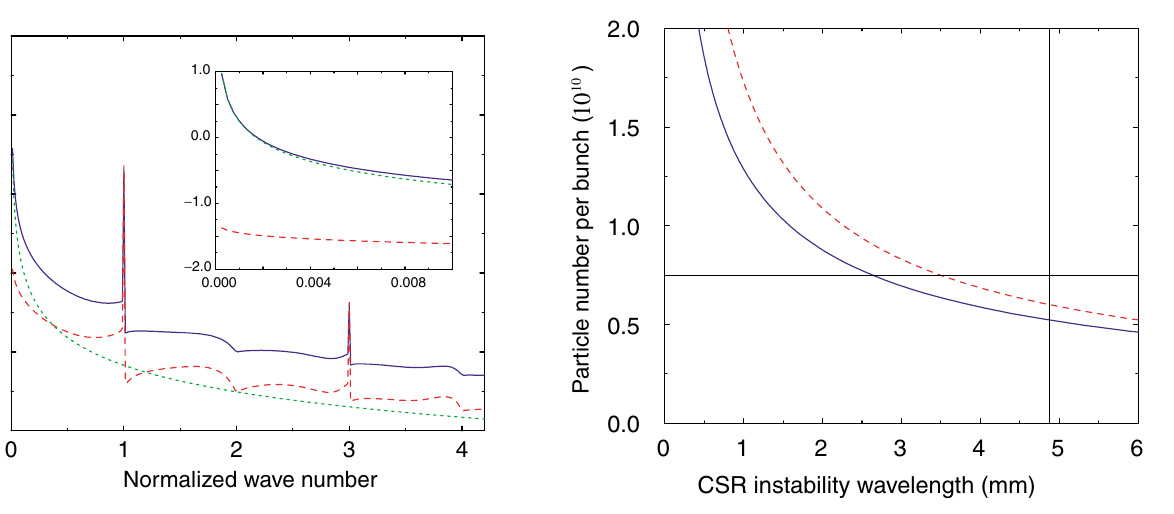
FIG. 2. (Color) The imaginary part of the normalized fre- FIG. 3. (Color) The threshold particle number as a function of quency (cid:12) as a function of the normalized wave number k=k 0 the CSR wavelength for the NLC main damping ring. The for the NLC main damping ring with negative momentum dashed curve is the result for the dipoles only, while the solid is the on-axis wiggler fundamental ra- compaction where k 0 curve takes into account the contributions from the dipoles and diation wave number defined in Eq. (14). The solid curve the wigglers. The vertical straight line is the approximate cutoff includes the entire CSR impedance while the dotted and wavelength according to Eq. (10). The horizontal straight line is dashed curves include either the steady state dipole CSR the nominal number of particles per bunch: 0 : 75 (cid:9) 10 10 . impedance or the wiggler CSR impedance, respectively. The inset shows a blowup of the low frequency region where the beam is